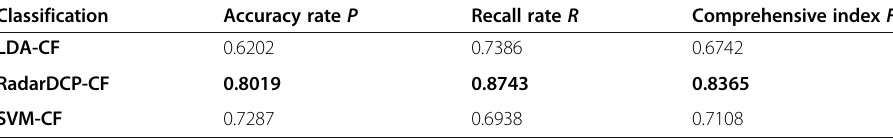
Table 5 Comparison results between LDA-CF, RadarDCP-CF, and SVM-CF on texts of radar